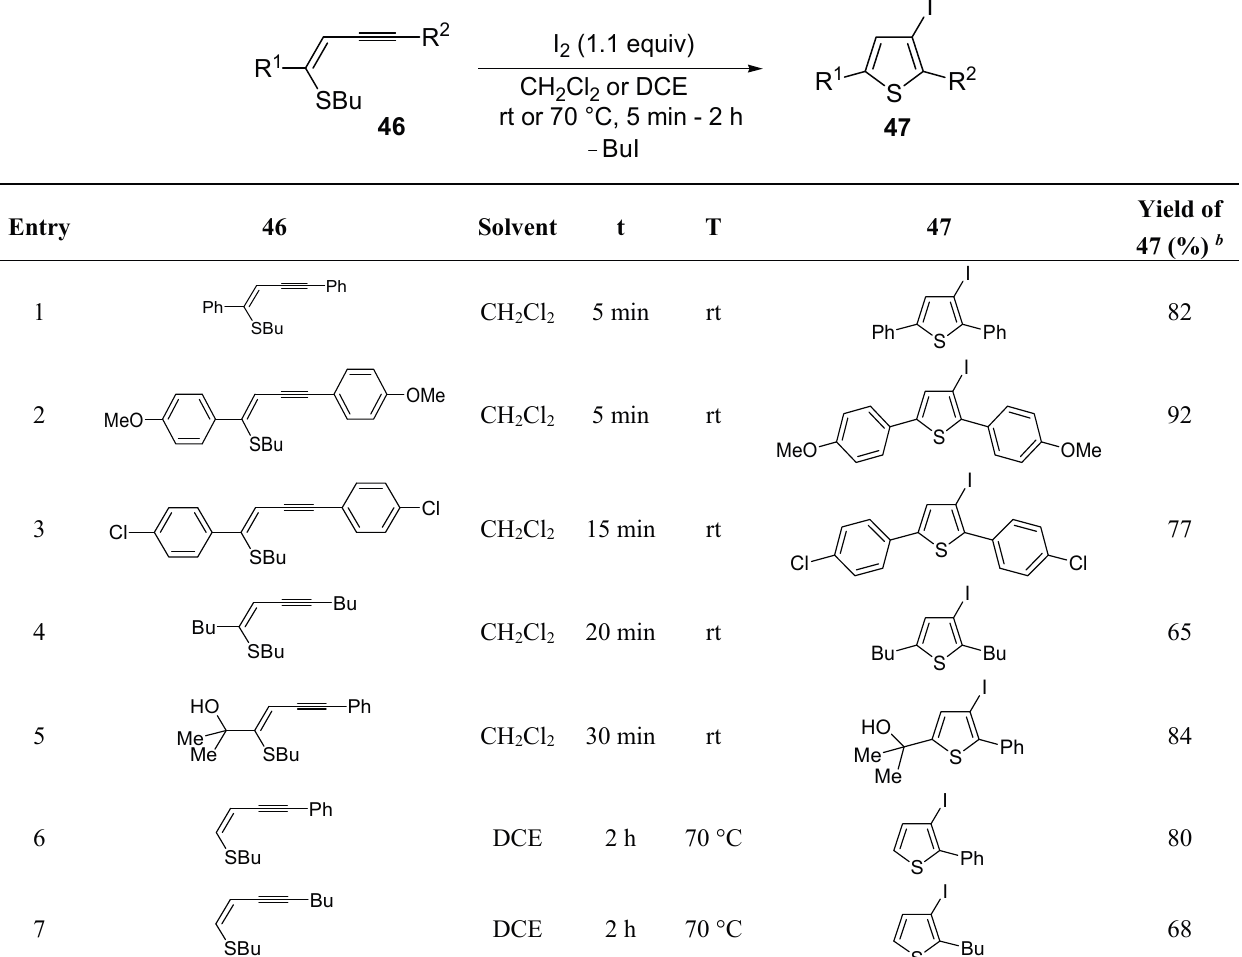
Table 6. Synthesis of 3-iodothiophenes 47 by iodocyclization of ( Z )-1-en-3-ynyl(butyl)sulfanes 46 a